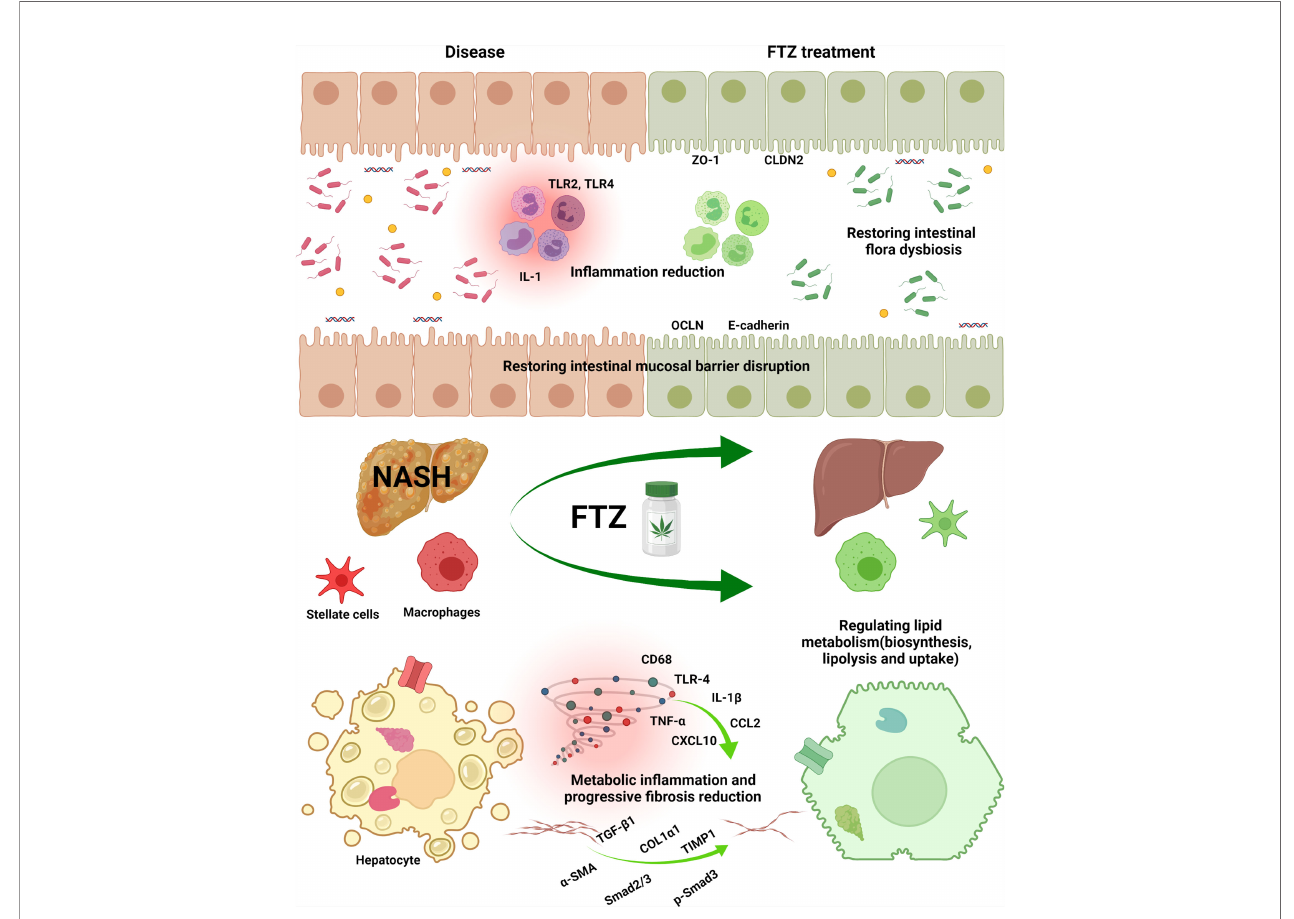
FIGURE 9 | FTZ attenuated HFD-induced hepatic steatosis, in fl ammatory responses, and fi brosis in mice. FTZ reduces lipotoxicity by regulating hepatic lipid synthesis, transport, and catabolism. Moreover, FTZ alleviates NASH and progressive liver fi brosis by inhibiting hepatic in fl ammation, stellate cell activation, and collagen deposition. These protective effects are achieved by modulating tight junctions, restoring intestinal barrier function, and improving the dysregulation of intestinal fl ora and its metabolites in